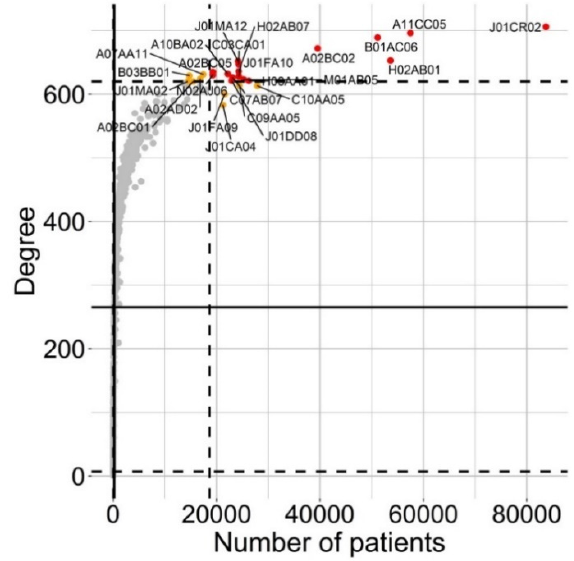
Figure A5. Relationship prescriptions and co-prescriptions in the DPN-ATCL5. The number of patients prescribed with an ATC i and the number of neighbours of that ATC i were displayed as a 2D scatter plot. Horizontal and vertical black lines display the 50th (solid line), 2.5th and 97.5th (dashed lines) percentiles. Each node is represented as a dot; coloured (orange and red) dots highlight subsets of ATC codes endowed with the higher values for the two metrics.